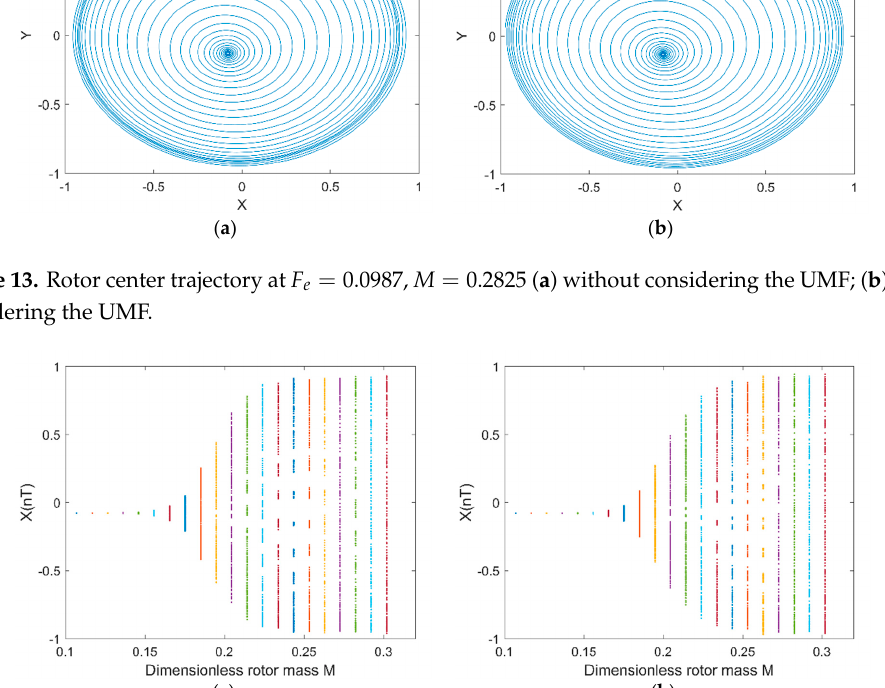
Figure 14. Bifurcation diagram: displacement in X-direction with dimensionless rotor mass 𝑀 .